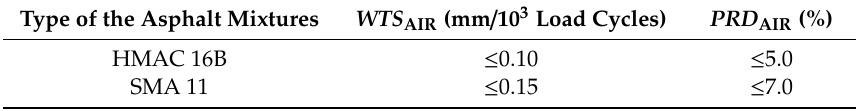
Table 4. Polish Technical Requirements WT-2 for the rutting resistance of HMAC 16B and SMA 11. Type of the Asphalt